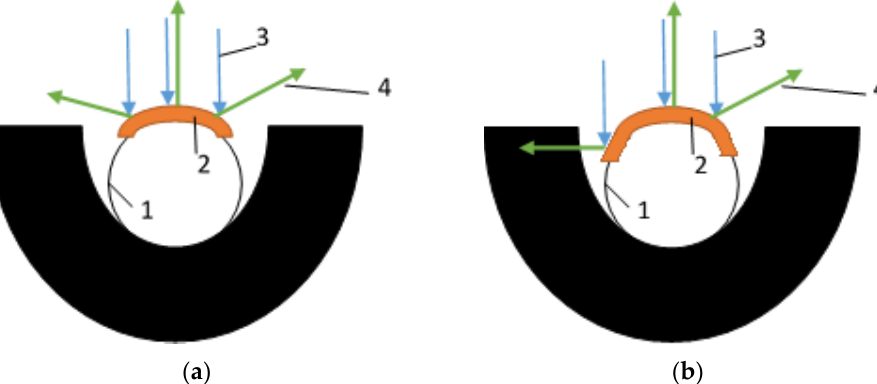
Figure 18. Mechanism of heat radiation reflection in fabric: ( a ) with coated top of fibre; ( b ) with coated top and side walls of fibre; 1—fibre, 2—coating, 3—incident radiation, 4—reflected radiation.